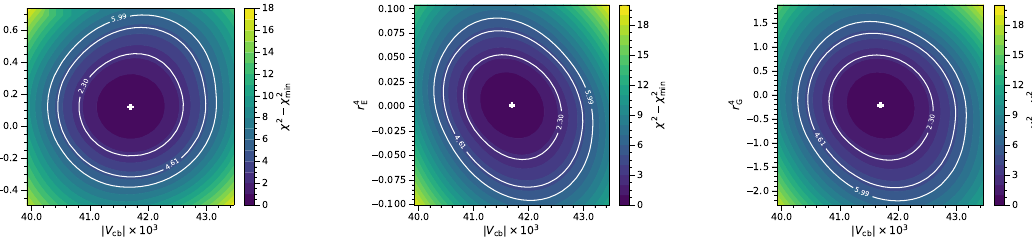
and r 4 . The minimum χ 2 , r 4 D E G